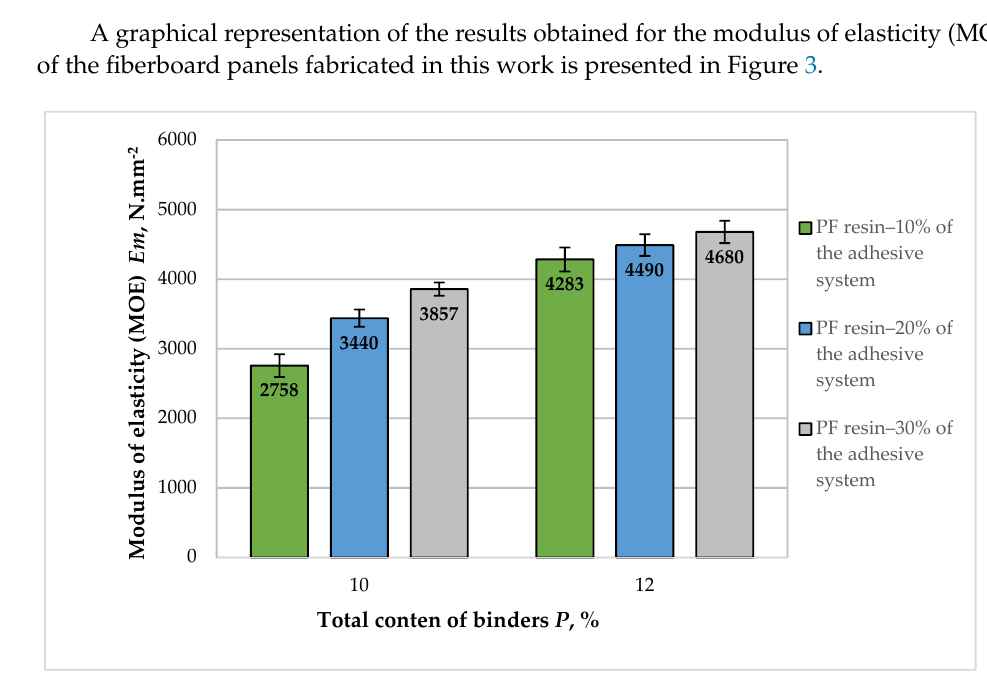
Table 3. ANOVA for the density of fiberboard panels bonded with HL and PF resin.